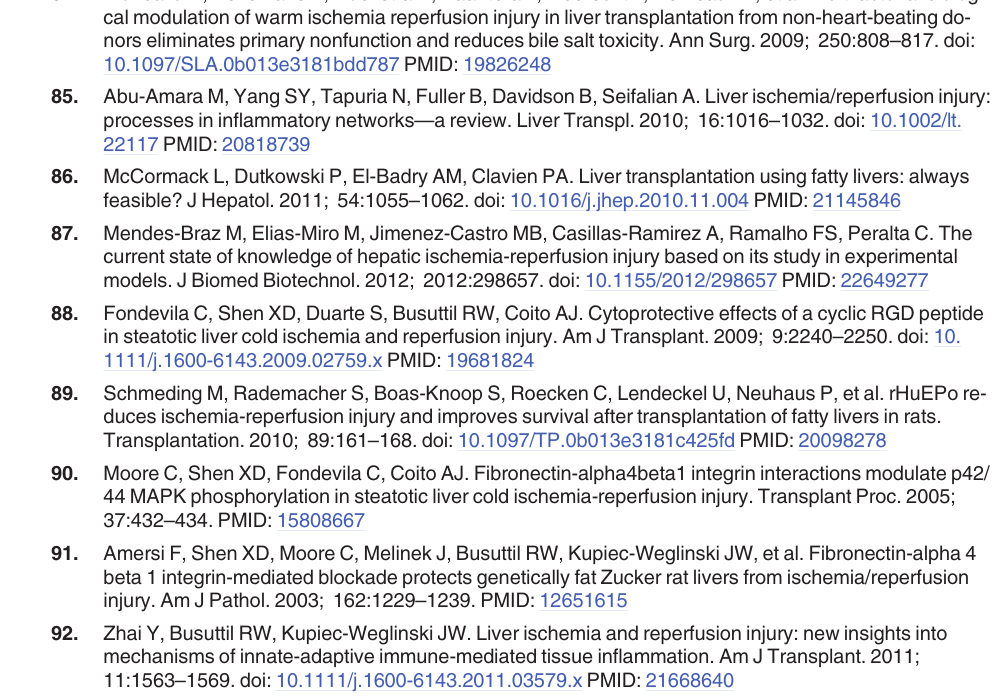
PLOS ONE | DOI:10.1371/journal.pone.0122214 April 28, 2015 16 /